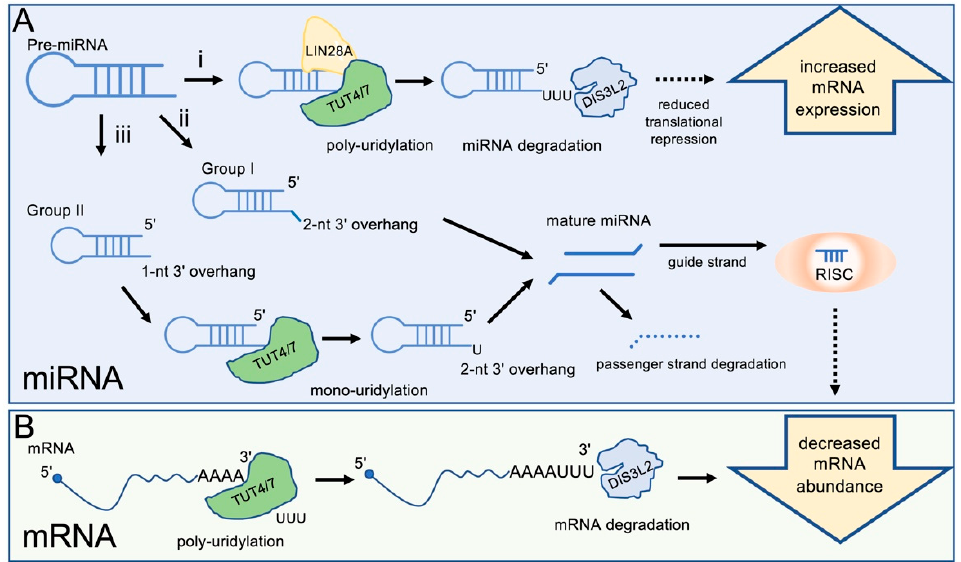
Figure 1. TUT4/7 regulate miRNA and gene expression levels. ( A ) miRNAs are regulated by TUT4/7 in multiple pathways: (i) Pre-miRNAs can be polyuridylated by TUT4/7 in the presence of LIN28A, a signal for degradation by DIS3L2. Decreased miRNA levels due to DIS3L2-mediated degradation increase target mRNA levels. (ii) Group I pre-miRNAs contain a 2-nucleotide 3 ′ overhang and can be processed by DICER to form the mature miRNA. This process occurs independently of TUT4/7 regulation of miRNAs. (iii) Group II pre-miRNAs contain a 1-nucleotide 3 ′ overhang and must be extended by one nucleotide at the 3 ′ end to form the necessary 2-nucleotide 3 ′ overhang for DICER processing. Mature miRNAs are processed into a guide (usually 5p) strand, which is incorporated into the RNA-induced silencing complex (RISC), and a passenger (usually 3p) strand, which is degraded. Mature miRNAs reduce expression of target mRNAs. ( B ) mRNAs can be 3 ′ polyuridylated by TUT4/7 and degraded by DIS3L2, decreasing gene expression.